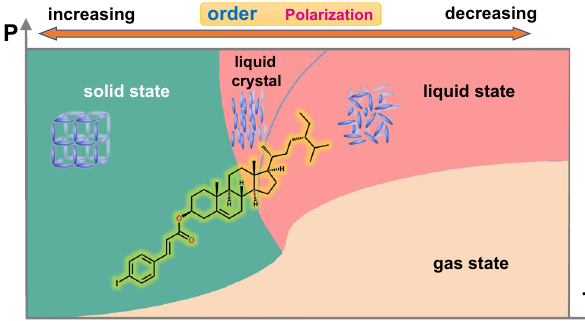
Fig. 1 | Guiding ideology for obtaining the ferroelectric 4I-CASS. 4I-CASS can show the biferroelectricity in both solid and liquid crystal phases. The light blue shapes represent the degree of molecular order in the solid, liquid crystal, and liquid phases. The inset molecule shows the molecular structure of